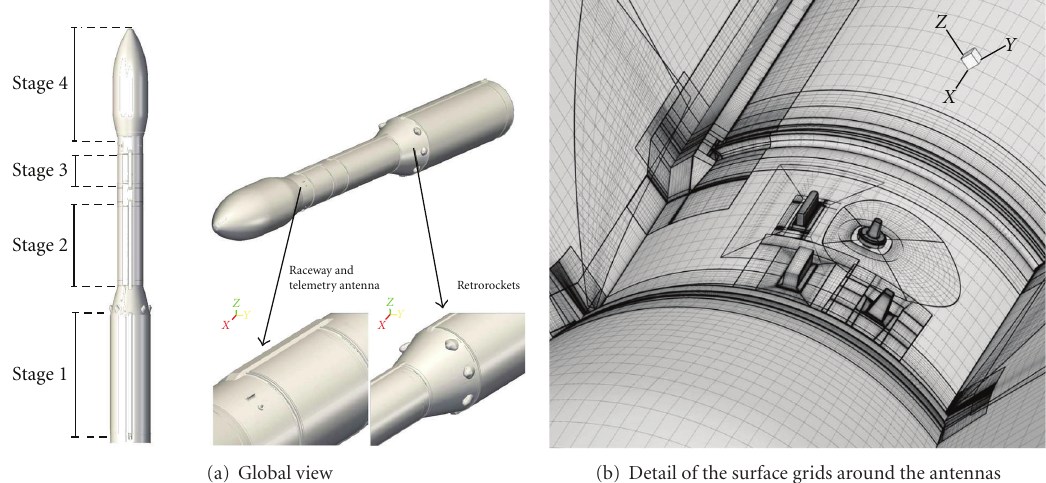
Figure 4: Launcher Vega of the European Space